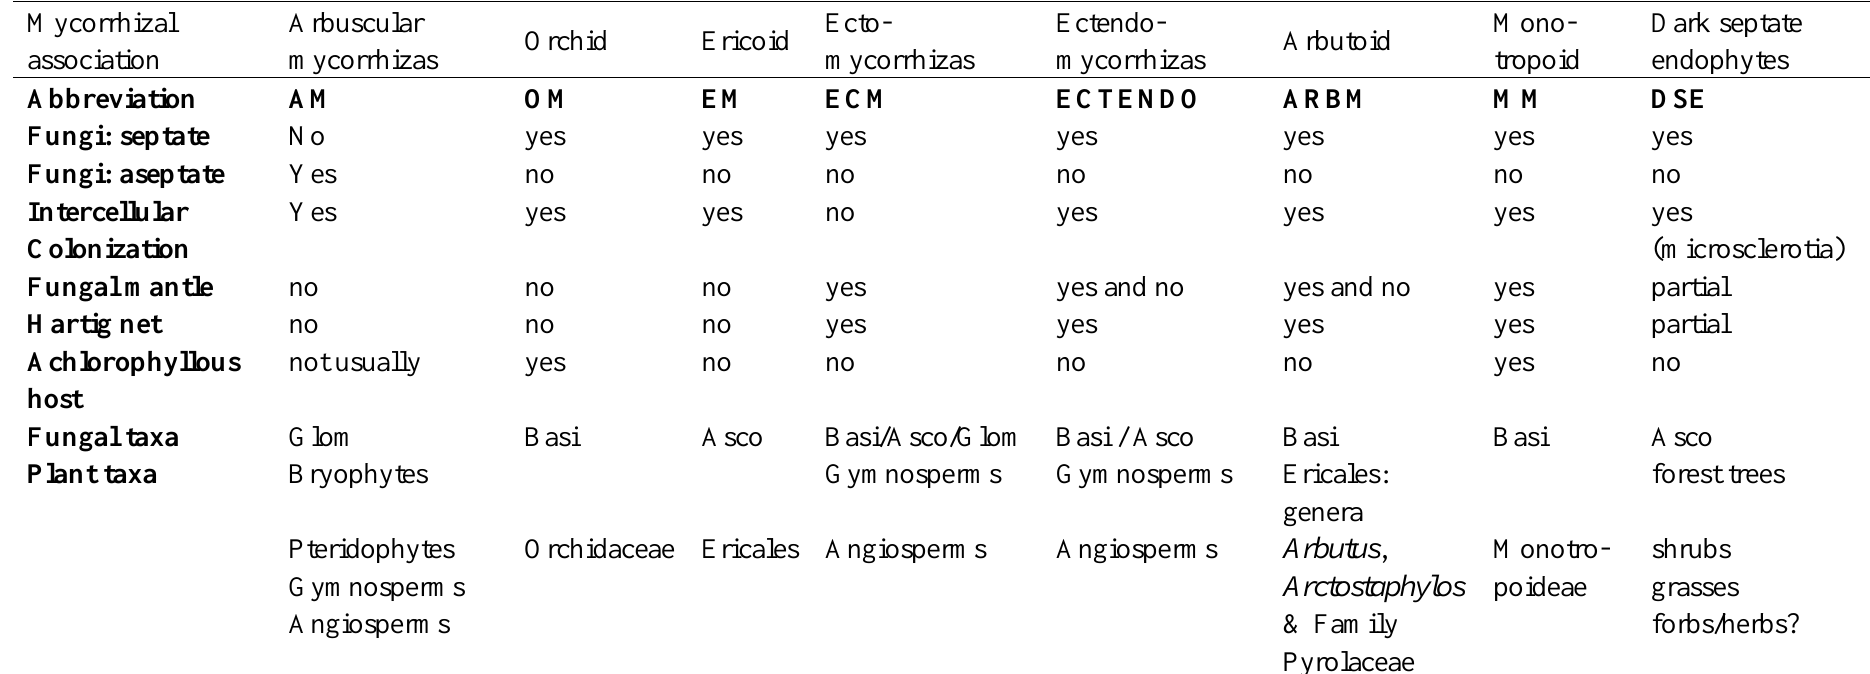
Table 3. Characteristics of mycorrhizal diversity and dark septate endophytes (adapted from Smith and Read [35] and Findlay